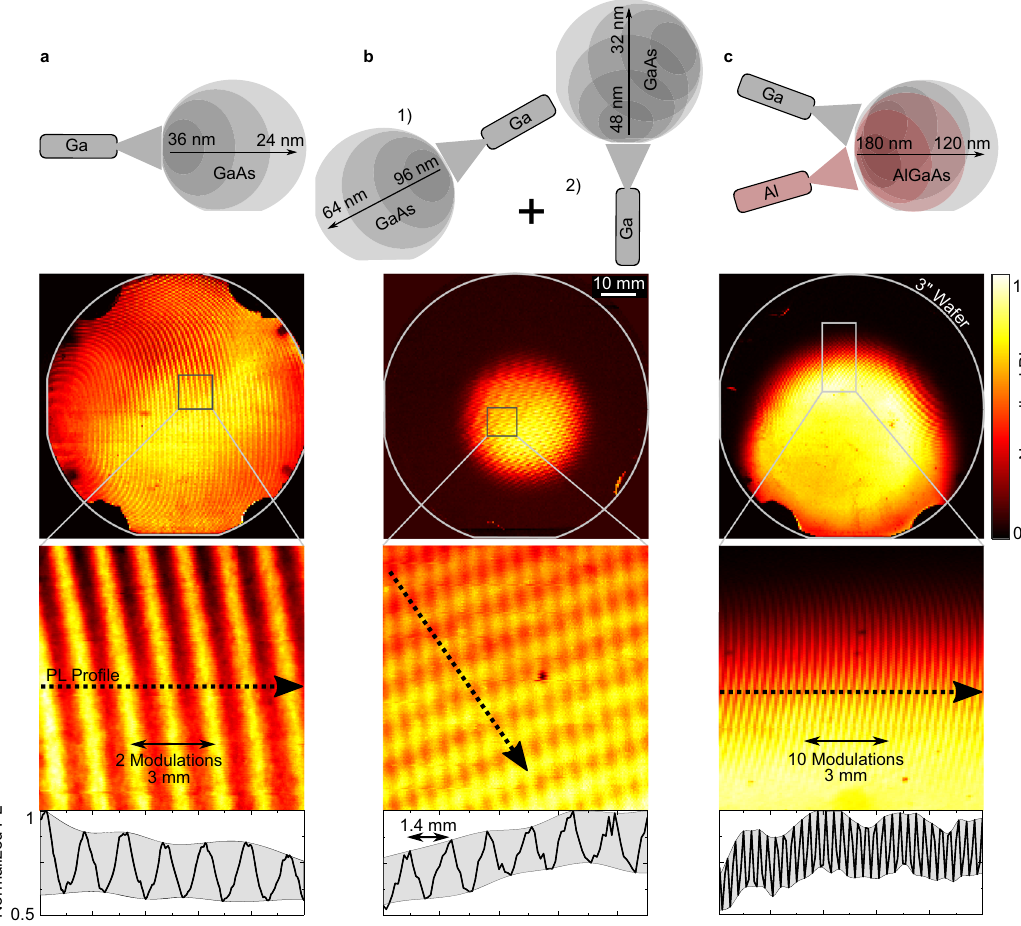
Fig. 4 Demonstration of epitaxial pattern control. QD PL intensity maps of a 30 nm GaAs PDL, b superposition of 80 and 40 nm GaAs PDL, and c 150 nm AlGaAs PDL. High-resolution maps of the marked areas are shown below. The normalized PL intensity along the black dotted line of the respective zoom- ins is presented in the bottom